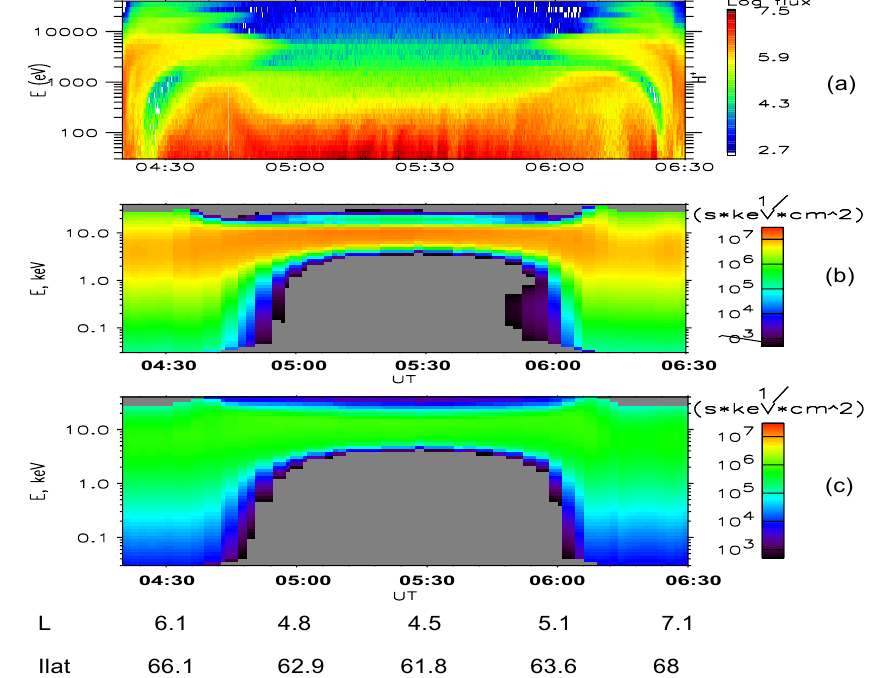
Fig. 12. Same as Fig. 10 but for the 11 April 2002